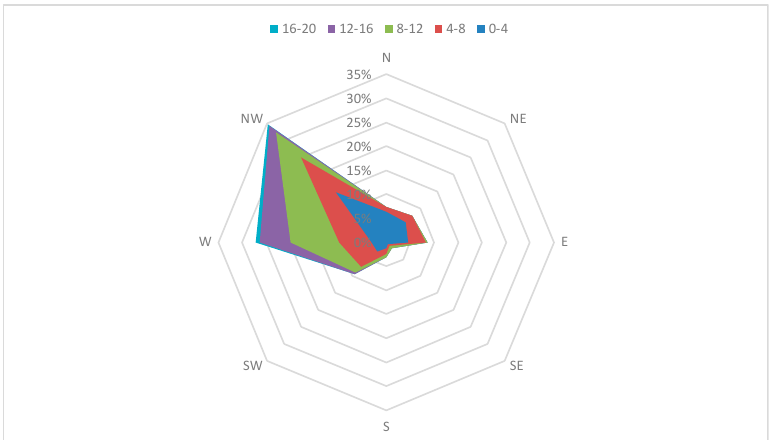
Figure 3. Wind rose recorded in Le Croisic in March April 2020. The wind speed intervals encountered during the campaign are reported above the graphic.